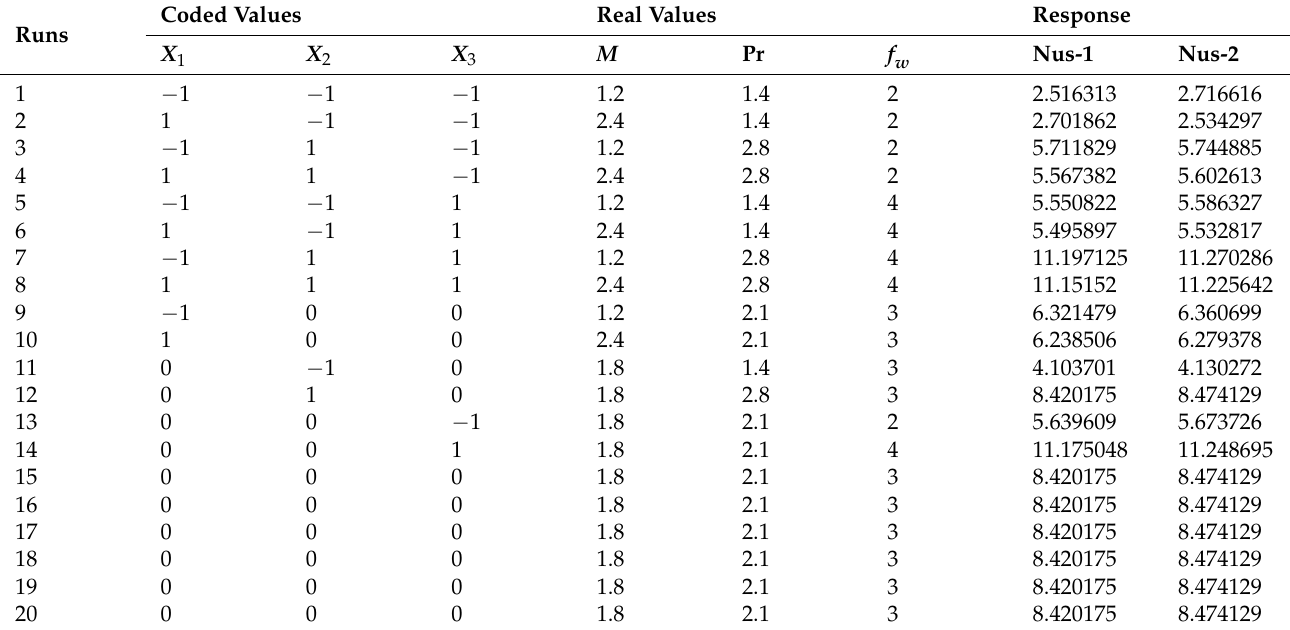
Table 4. Design and results of heat transfer rate experiments ( Nur ).